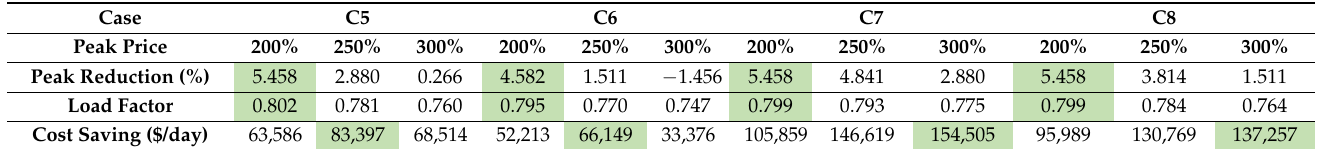
Table 15. Cases [C5–C8] results.